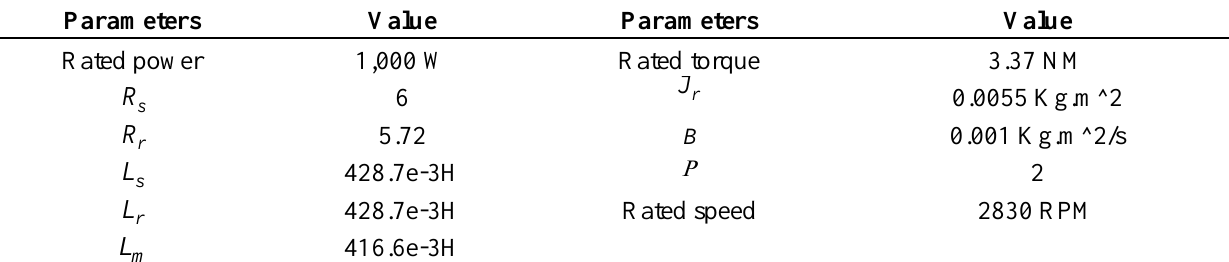
Table 2. Induction motor